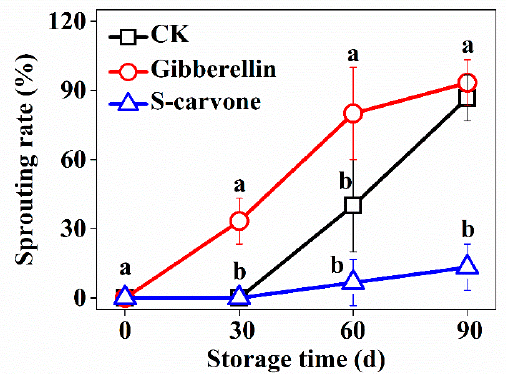
Figure 1. Effects of gibberellin and ( S )-carvone on sprouting rate in potato tubers during 4 °C low temperature storage. Error bar represents level of significance ( p < 0.05) among replicated samples ( n = 45). Means with the same letters are not statistically different according to the least significant difference test at p < 0.05.